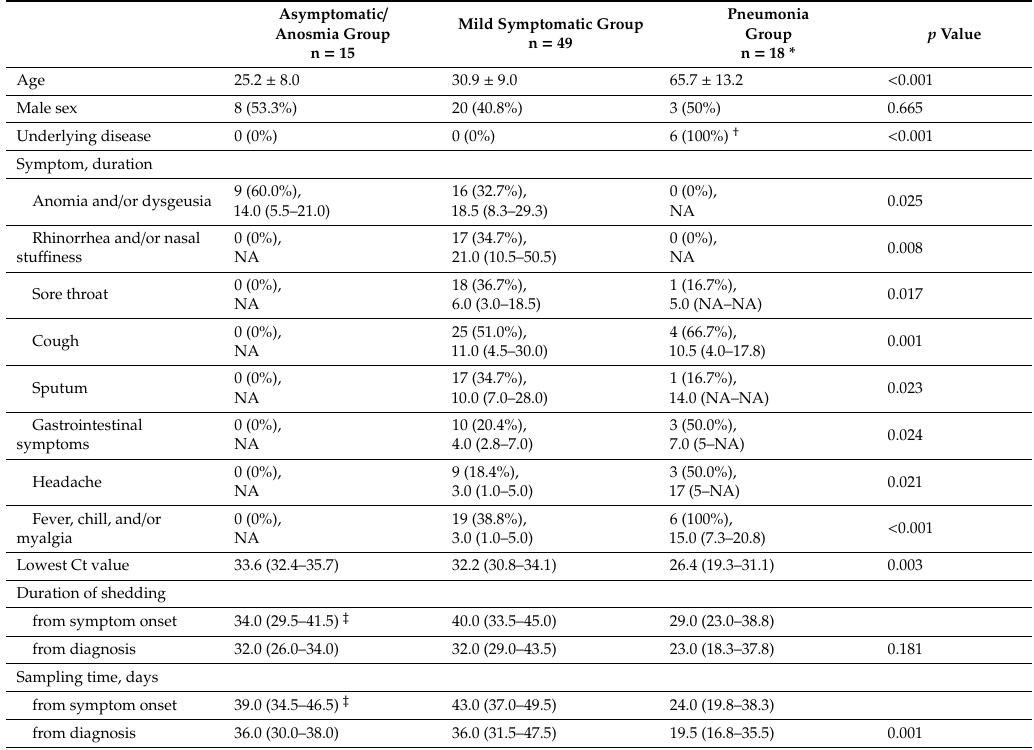
Table1. Clinicalcharacteristicsofasymptomatictoseverecoronavirusdisease2019(COVID-19)patients. Asymptomatic / Anosmia